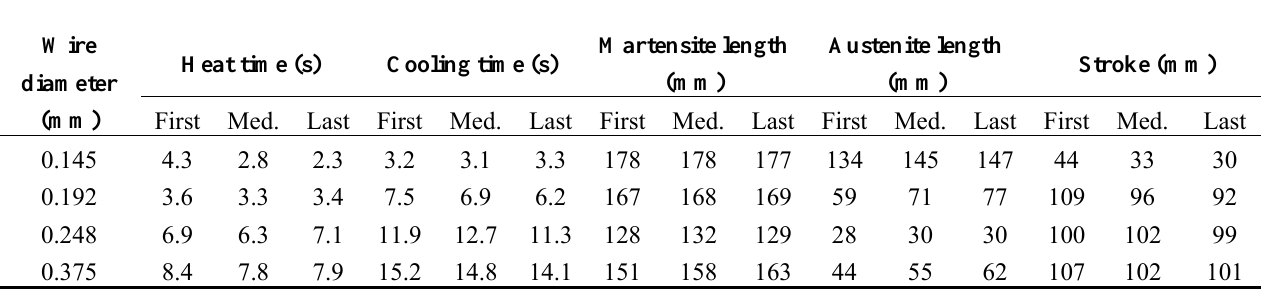
Table 4. The averaged first, median and last values for the wire diameter